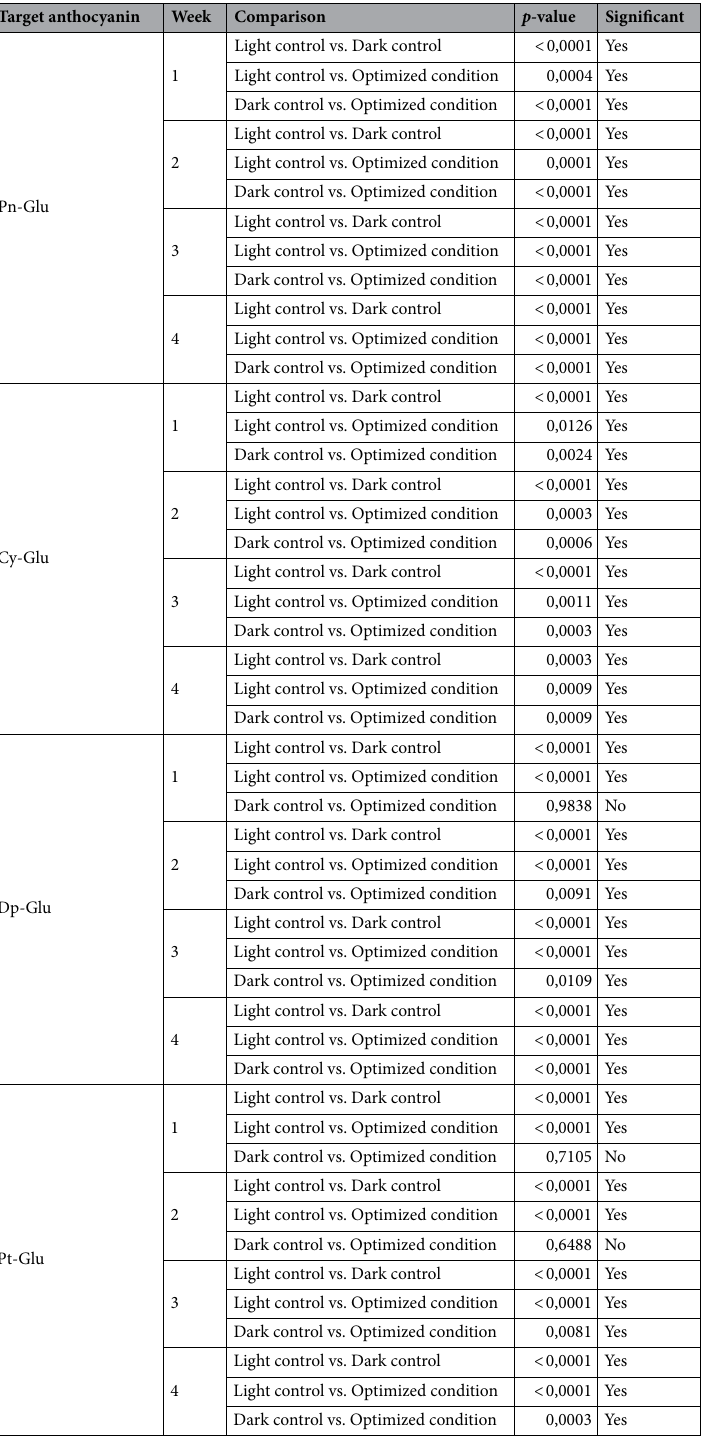
Table 5. p -values of Tukey’s multiple comparison tests for the comparison of concentrations of the four target anthocyanins from cultures cultivated under different lighting conditions. Tukey’s multiple comparison test was done using GraphPad Prism v8.4.3 (GraphPad Software, San Diego, CA, USA). A significance (α) level of 5% was